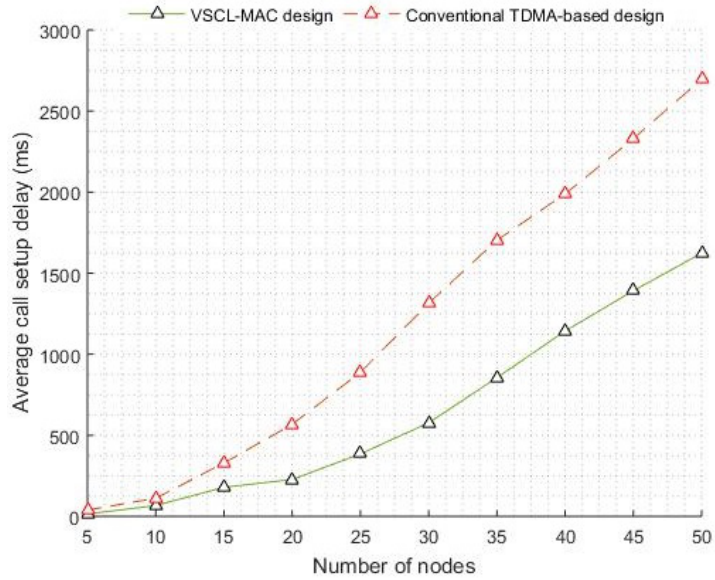
Figure 17. Average call setup delay for VSCL-MAC and TDMA-based MAC